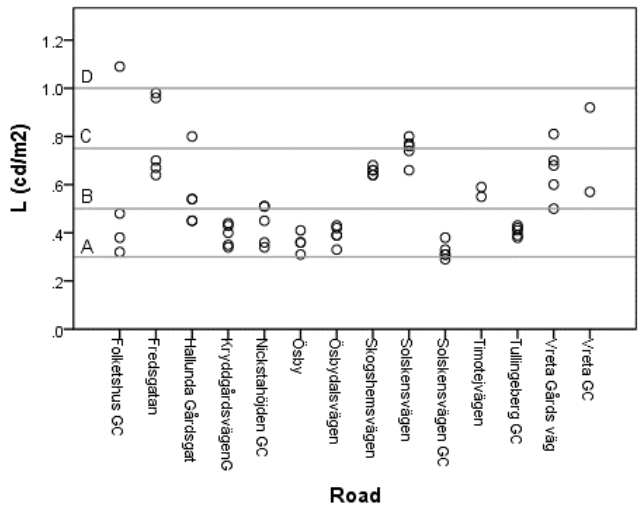
Figure 4. Average road surface luminance values ( L , cd/m 2 ) measured for the 14 roads studied, relative to lighting class boundaries A–D (horizontal lines). A = M6/S4; B = M5/CE5/S3; C = M4/CE4/S2; D = M3/CE3/S1, where M3–M6 are lighting classes with their comparable European Standard CE ‐ series and S ‐ series classes according to [21].